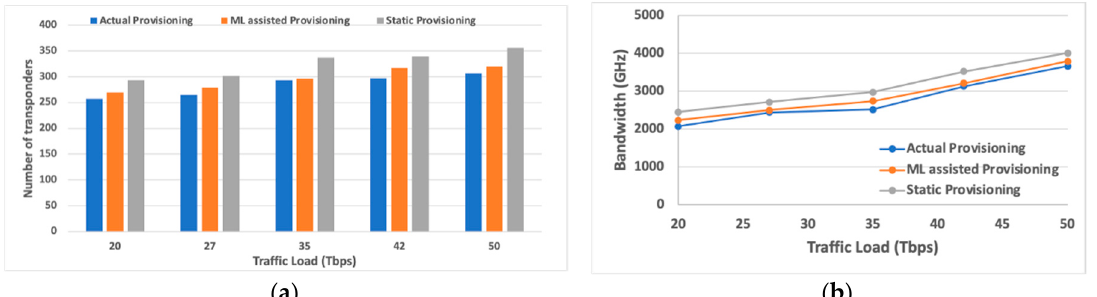
Figure 8. ( a ) The number of utilized transponders and ( b ) the bandwidth utilization in the actual, machine learning assisted and static provisioning scenarios for various traffic loads.